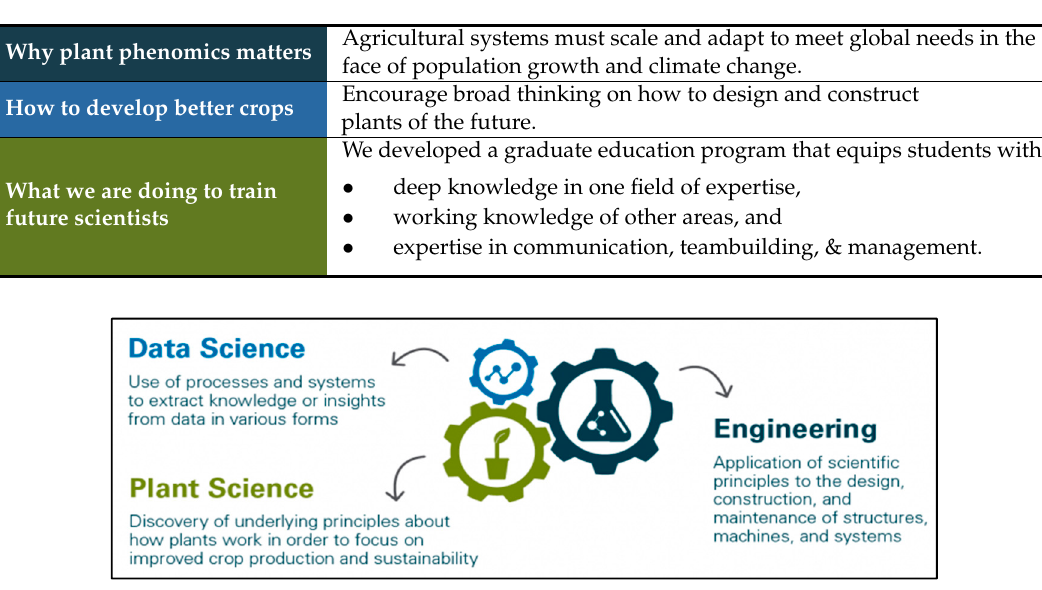
Table 1. Motivation for developing the P3 graduate specialization at Iowa State University.